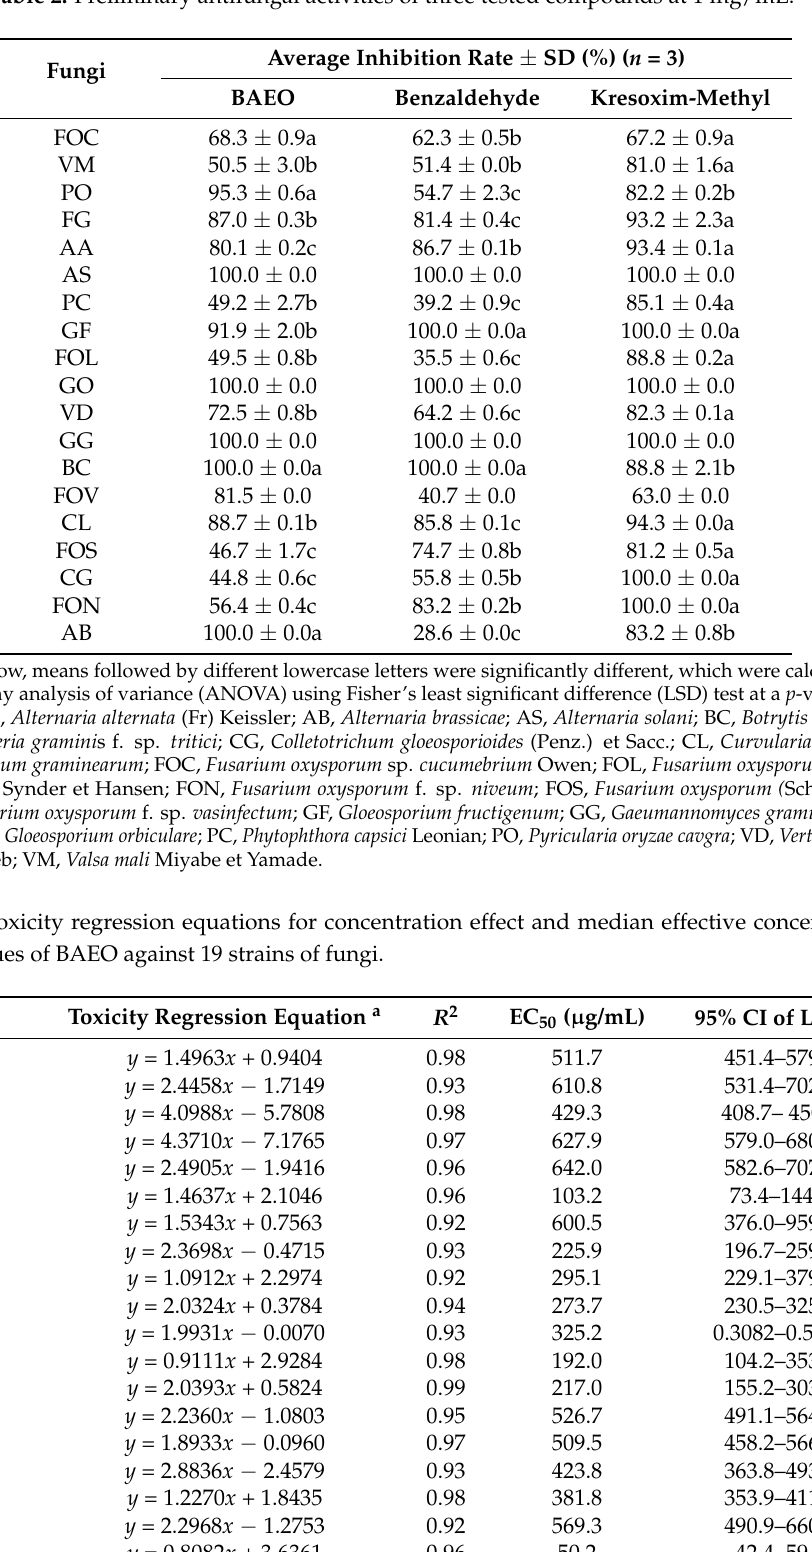
Table 2. Preliminary antifungal activities of three tested compounds at 1 mg/mL.